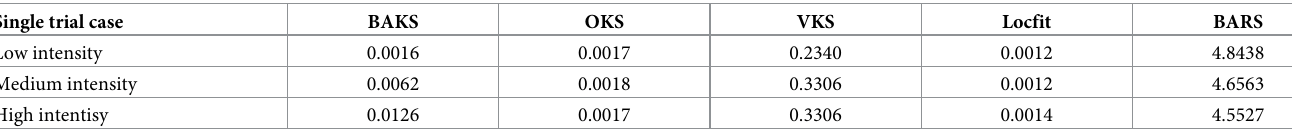
Table 2. Average runtime comparison of BAKS with other methods (in second). Single trial